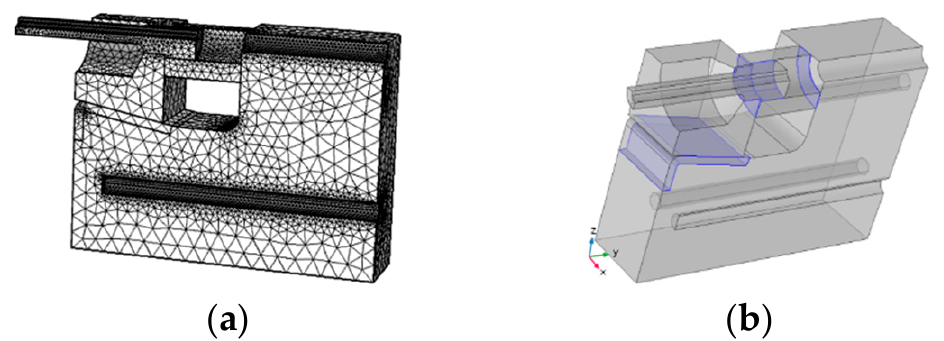
Figure A2. ( a ) Mesh of the system, ( b ) Mechanical parameterization for the quasi- incompressible assembly: pressure contact of 10 7 N/m².